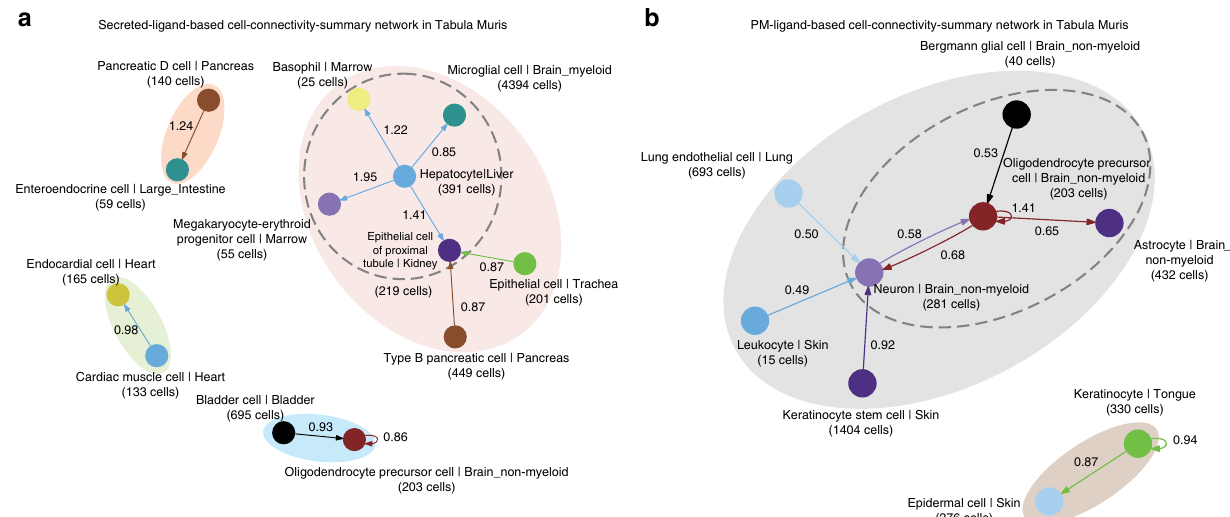
Fig. 5 Putative secreted and plasma-membrane-ligand mediated communities identi fi ed in Tabula Muris. Visualisation of cell types connected by the top ten summed-speci fi city edges in Tabula Muris based on a secreted ligands and b plasma-membrane ligands. Coloured shadows highlight the isolated communities found in each network, edge labels correspond to the summed-speci fi city weight of the edge. Dashed oval in a highlights highly speci fi c signalling from hepatocytes to multiple cell types via secreted ligands. Dashed oval in b highlights a set of four brain-derived cell types communicating via plasma-membrane